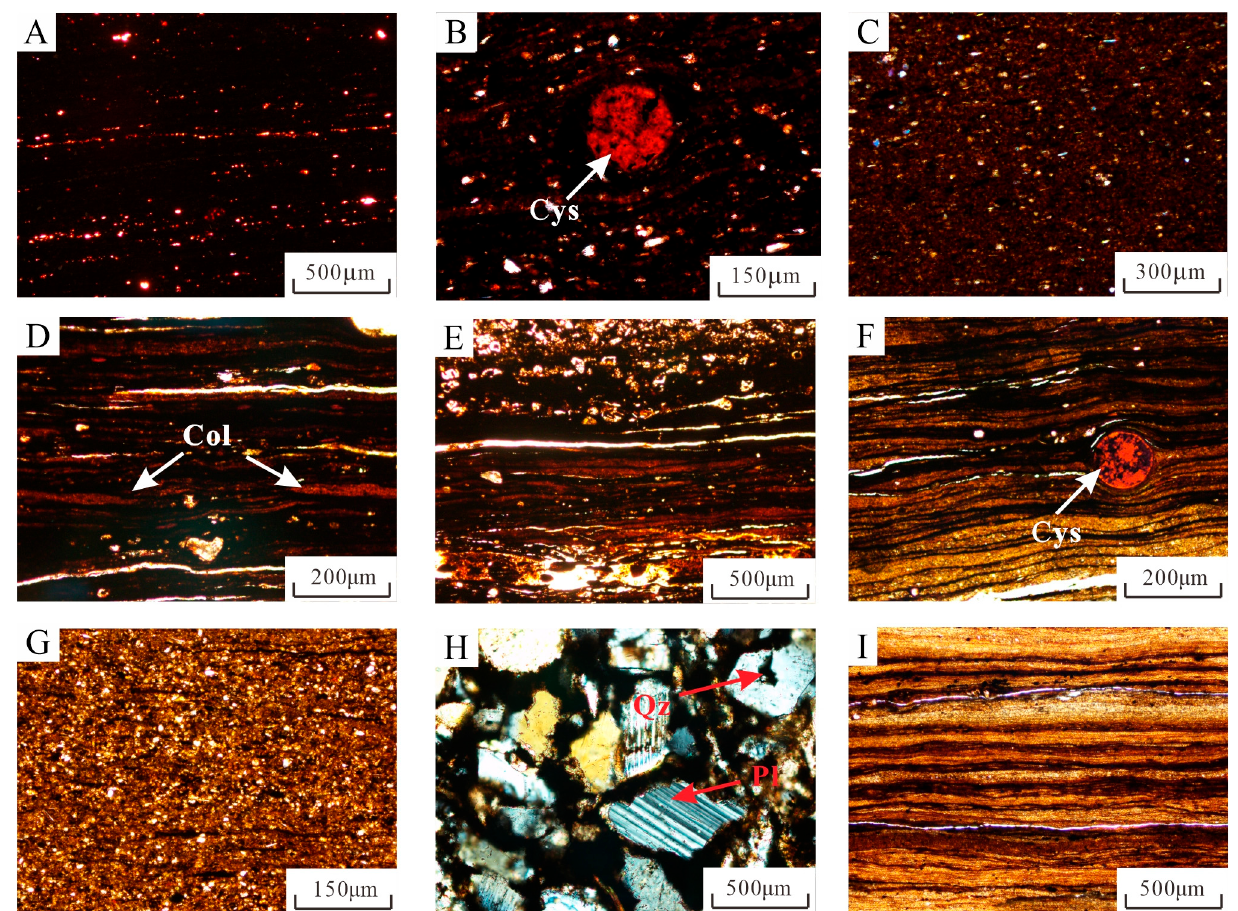
Figure 5. Microscopic characteristics of fine-grained sedimentary lithofacies in the Chang 7 member, Ordos Basin. ( A ) Quasi-laminated clayey shale facies with the intermittent distribution of organic matter and observed bright detrital minerals, Sample 1; ( B ) quasi-laminated clayey shale facies with metasomatic replacement of algal fossils by red collophanite, Sample 1; ( C ) blocky silty mudstone facies with underdeveloped laminations, Sample 11; ( D , E ) quasi-laminated silty shale facies with discontinuous organic matter and numerous inclusions of collophanite, Sample 8; ( F ) laminated silty shale facies with highly developed laminations and algal fossils, Sample 9; ( G ) blocky mixed mud- stone facies with the dotted distribution of organic matter and many detrital particles, Sample 21; ( H ) blocky mixed mudstone facies (under the cross-polarized light) with observed quartz and feld- spar particles, Sample 21; ( I ) laminated argillaceous siltstone facies with alternating sandy and clayey laminations, Sample 18. Cys = Cystocarp fossil; Col = Collophanite; Qz = Quartz; Pl = Plagio- clase.